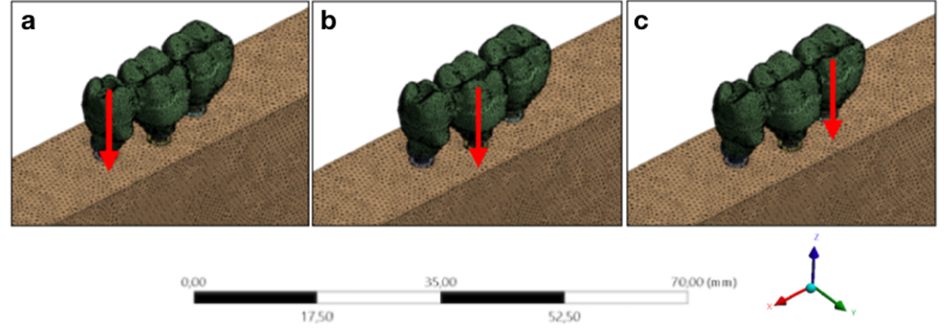
Figure 4. Analysis configuration for different axial loads. Legend: ( a ) Loading point A; ( b ) Loading point B; ( c ) Loading point C.